Question: Is the quantity shown trending increasing or decreasing?
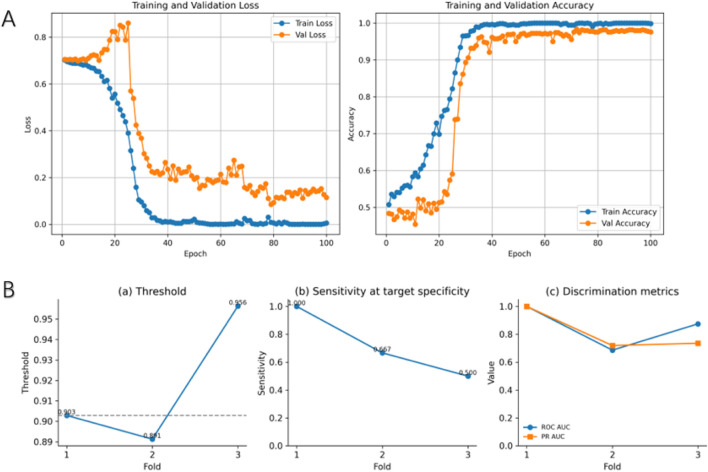
Answer: decreasing